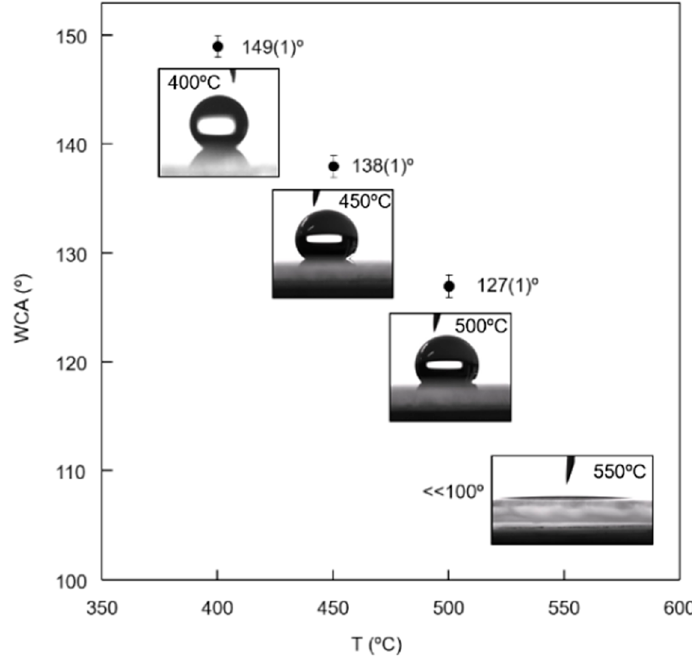
Figure 11. Water contact angle of the coating aged for 5 days and dipped four times at different curing temperatures.